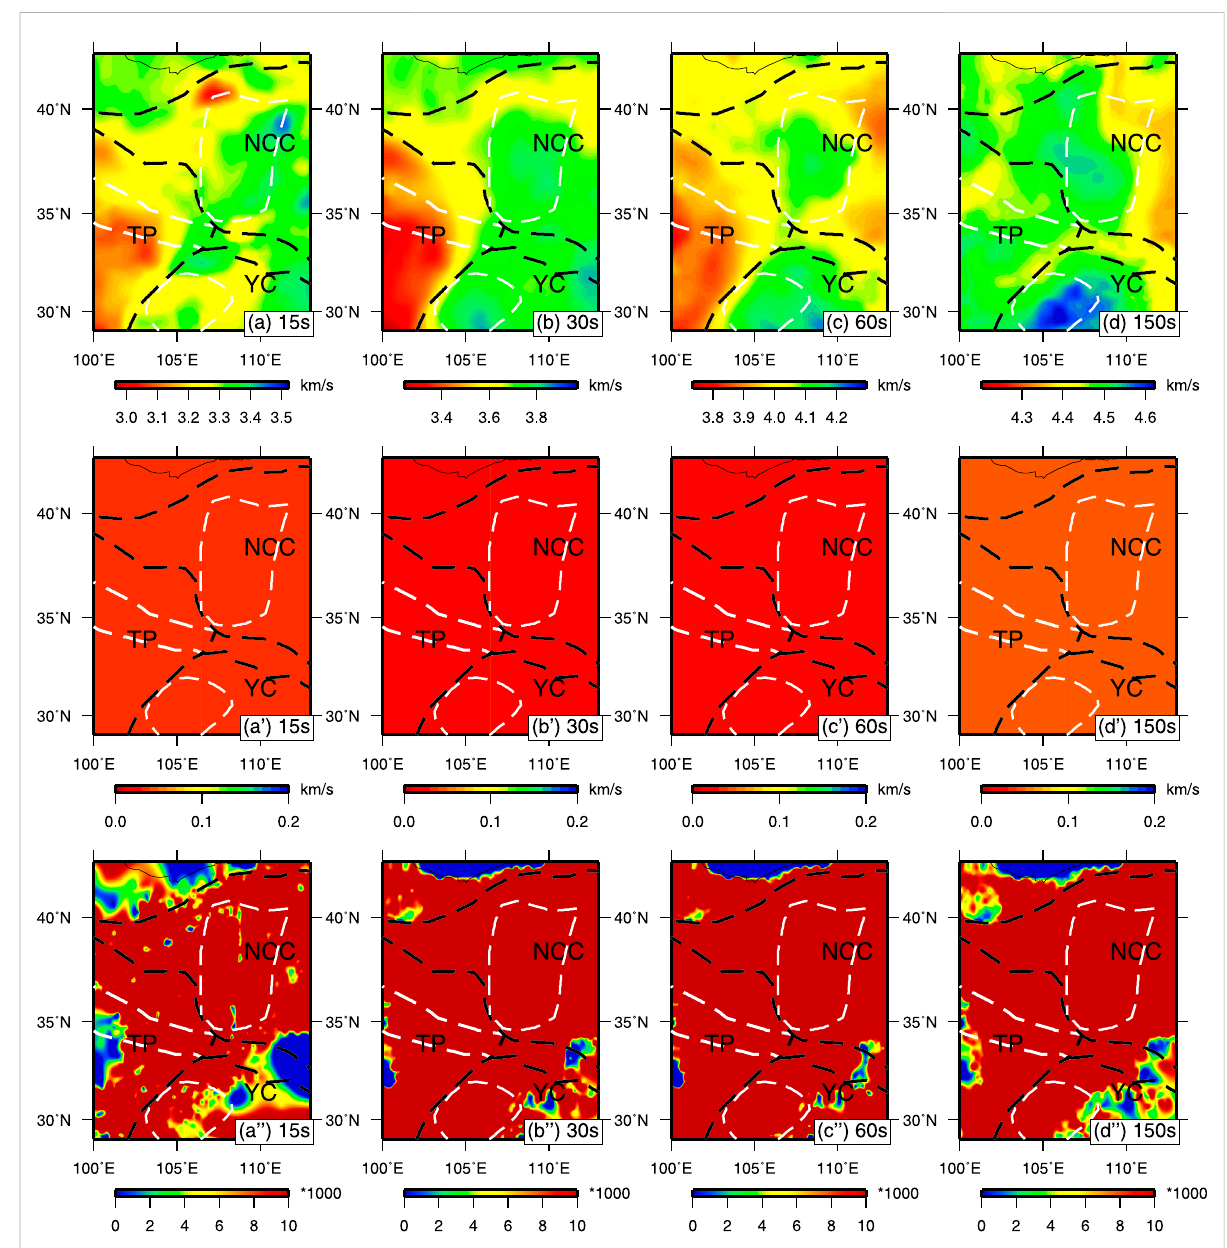
TheRayleighwavephasevelocityimages (A – D) ,thecorrespondinguncertaintyimages (A ’– D ’ ) andthedensityimagesofsurfacewaves (A ’’– D ’’ ) inNETibetanPlateauatdifferentperiodsbasedonthesurfacewaveEikonaltomographymethod.Thedottedlinesindicatetectonicunitboundaries, as shown in Figure